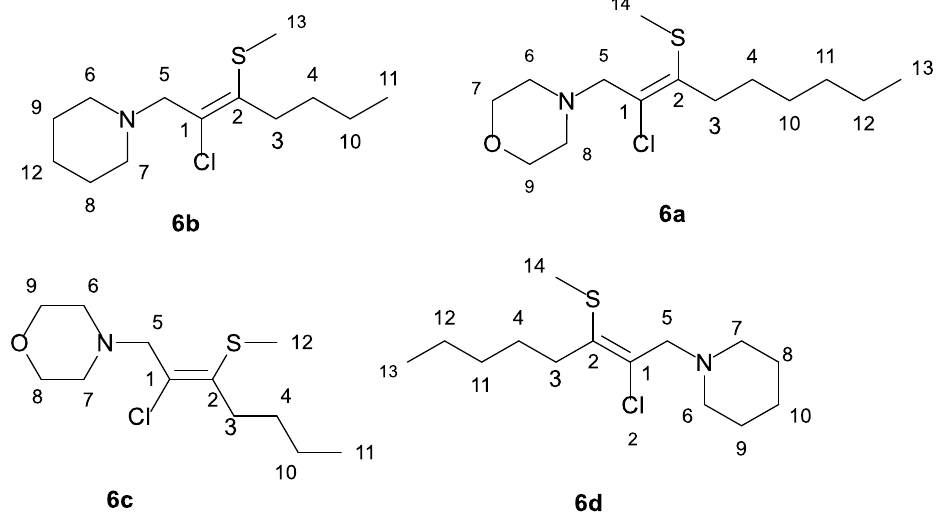
Figure 3. The numbering of atoms in the 13 C- and 1 H-NMR spectra of the compounds 6a – d .